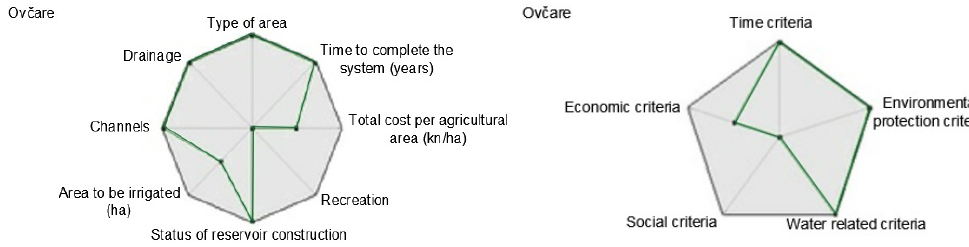
Figure 8. Result of alternative Ovčare analyses for Scenario 1 [23].